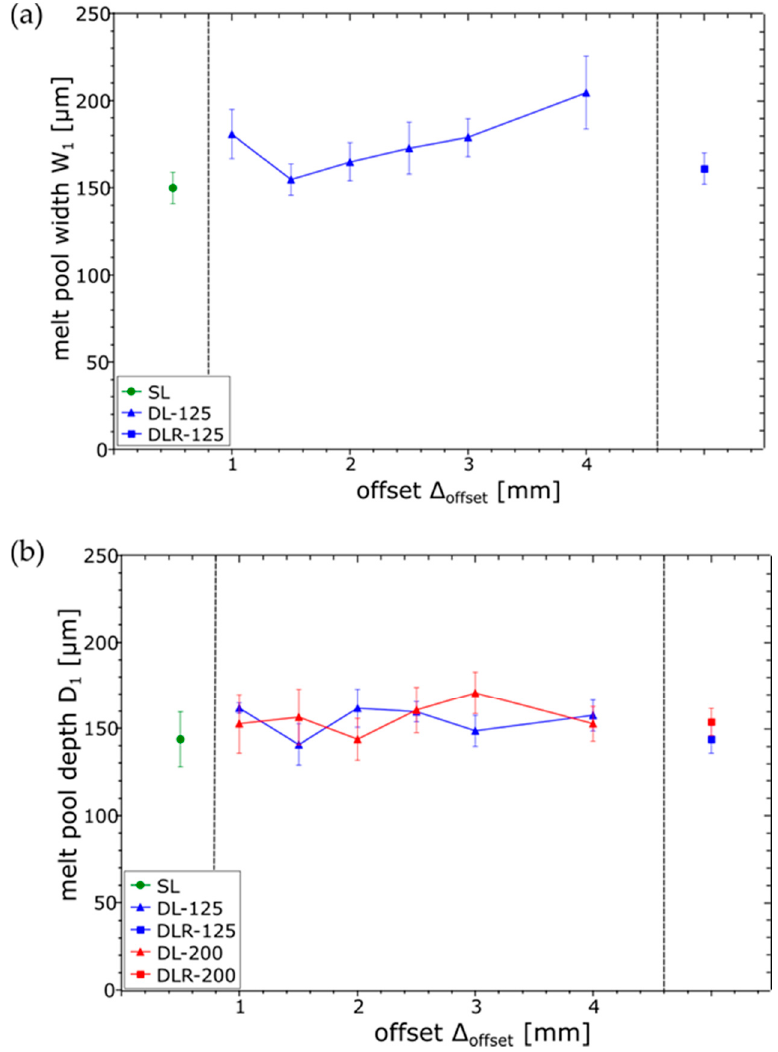
Figure 10. Measured melt pool dimensions (( a ) width W 1 and ( b ) depth D 1 ) in top layer resulting from laser 1 for the examined process parameter sets.